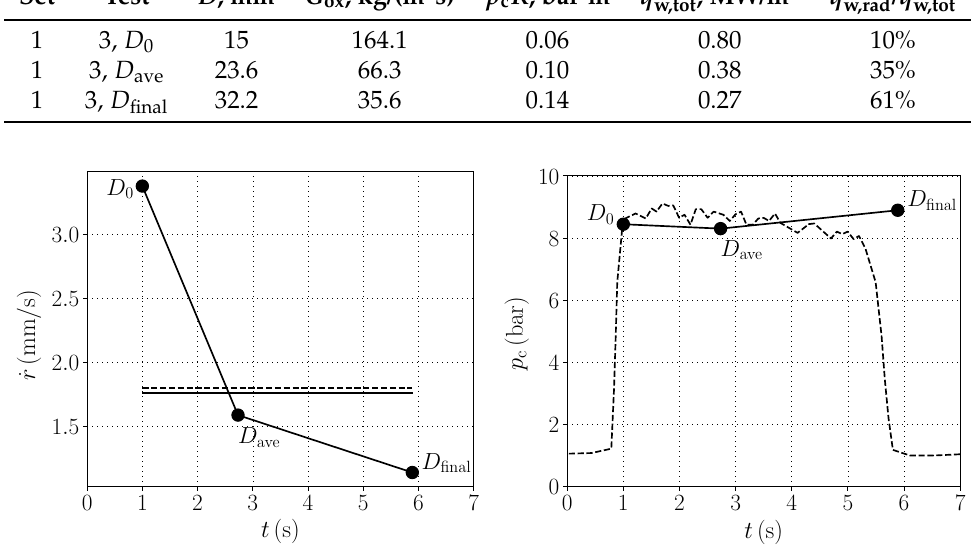
Figure 15. Time evolution of regression rate and pressure for test 3 of set 1. Dashed lines indicate experimental data taken from [13], while numerical data are shown with circles connected by solid lines. The horizontal solid line represents the integral average of the numerical regression rate